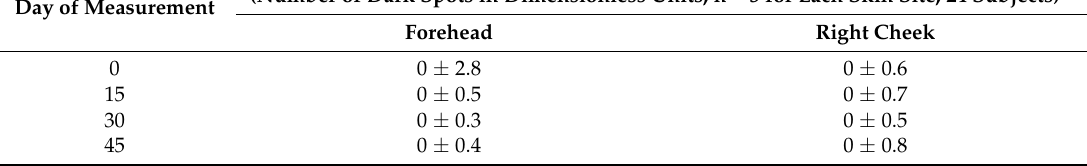
Table 3. Average results of the skin pigmentation evaluation on the forehead and the right cheek of volunteers.